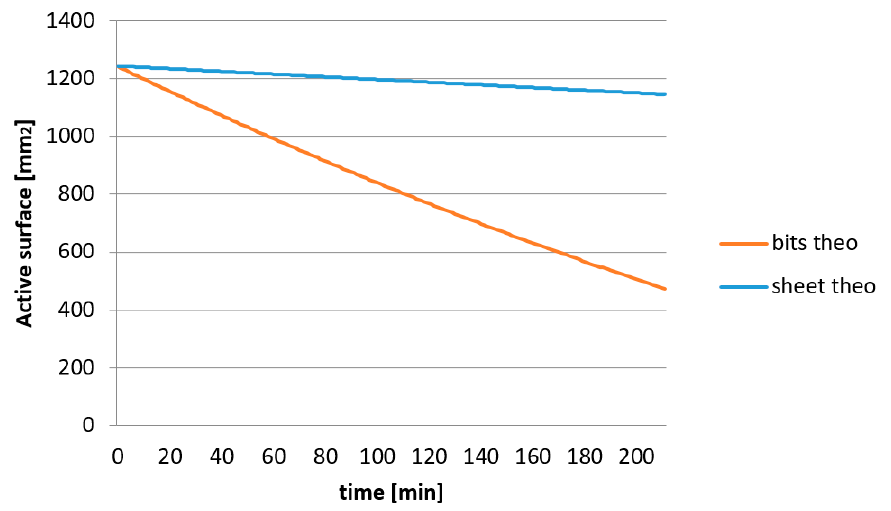
Figure 5. Comparison of the theoretical active aluminum surface for 104 sheet metal chips of 2 × 2 × 0.5 mm 3 (bits) and a plate (sheet) of aluminum A1 of 20 × 30 × 0.5 mm 3 .